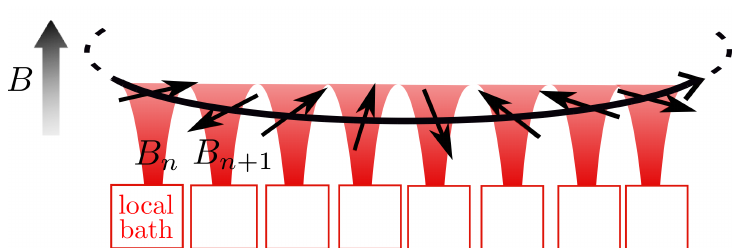
Figure 1: Schematic figure of the interacting spin chain with local coupling to the environment. Each spin is coupled to a local bath via the spin component parallel to the magnetic field of the Ising